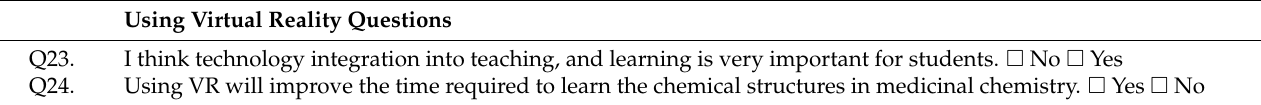
Table 4. Questions to identify students’ previous use of